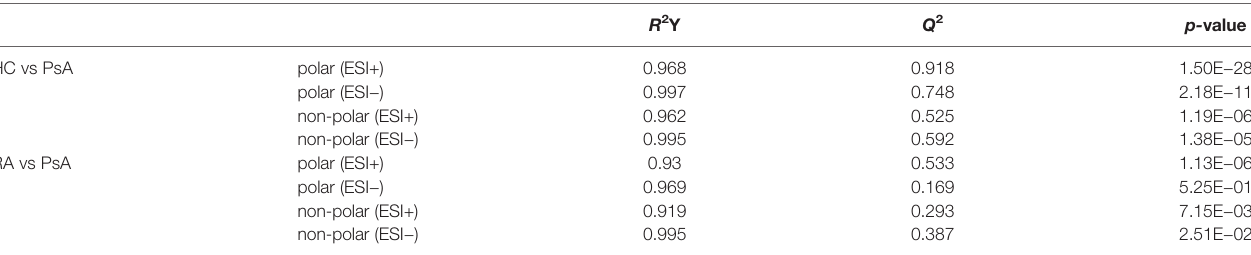
TABLE 2 | The parameters of OPLS-DA model.